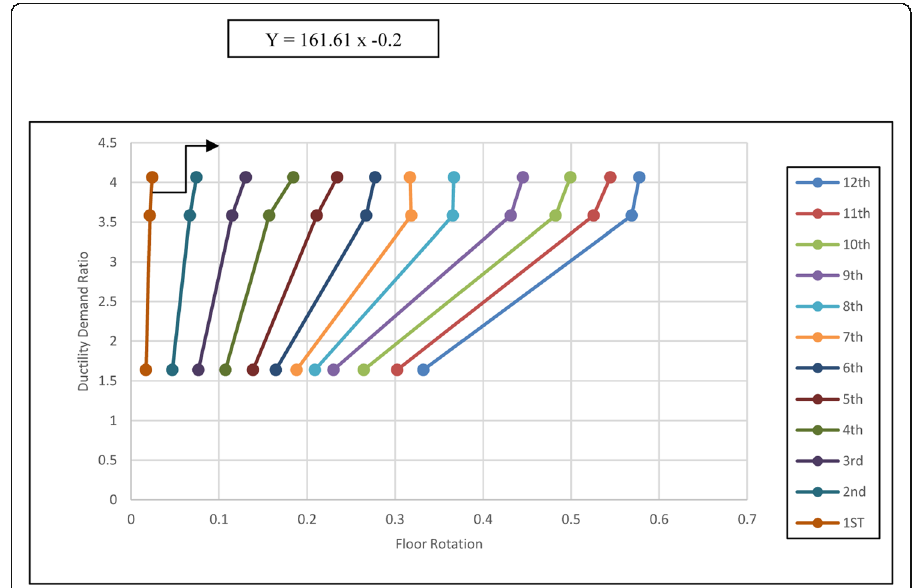
Fig. 35 Comparison of floor rotation — ductility demand ratio for stiff side elements located 16 m from center of mass for (DS-3-1, DS-3-2, and DS-3-3) (color should be used for this figure)